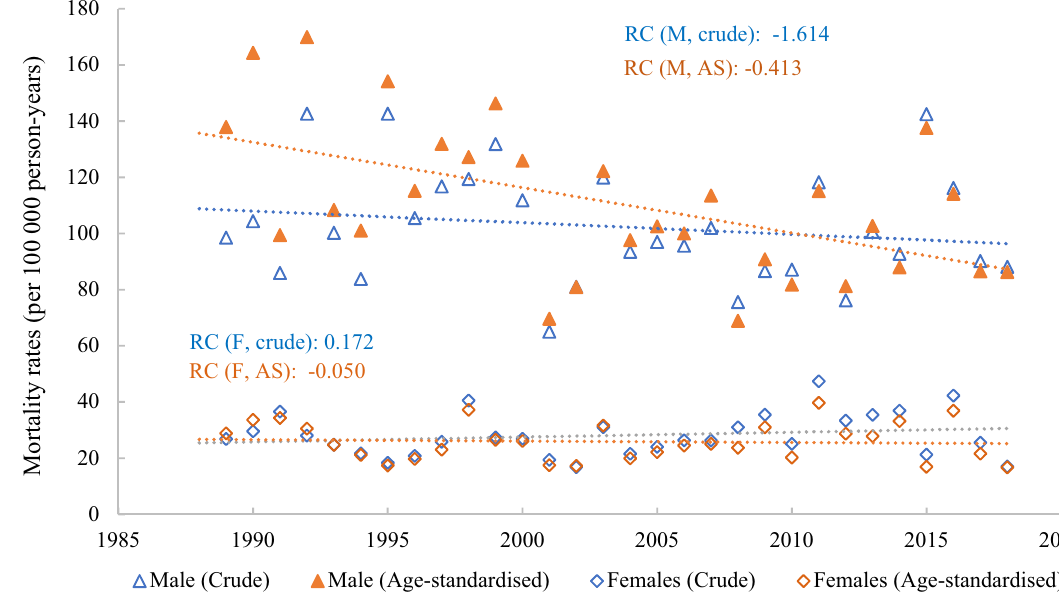
Figure 2. Crude and age-standardised mortality rates from external causes between 1989 and 2018 in males and females with linear trends (RC: linear regression coefficient; M: males; F: females; AS: age-standardised). Age- standardised 95% confidence interval of Crude mortality rate the age-standardised rates mortality rate M F M All-cause mortality 879.8 652.6 1092.9 545.8 1072.9, 1113.0 533.9,